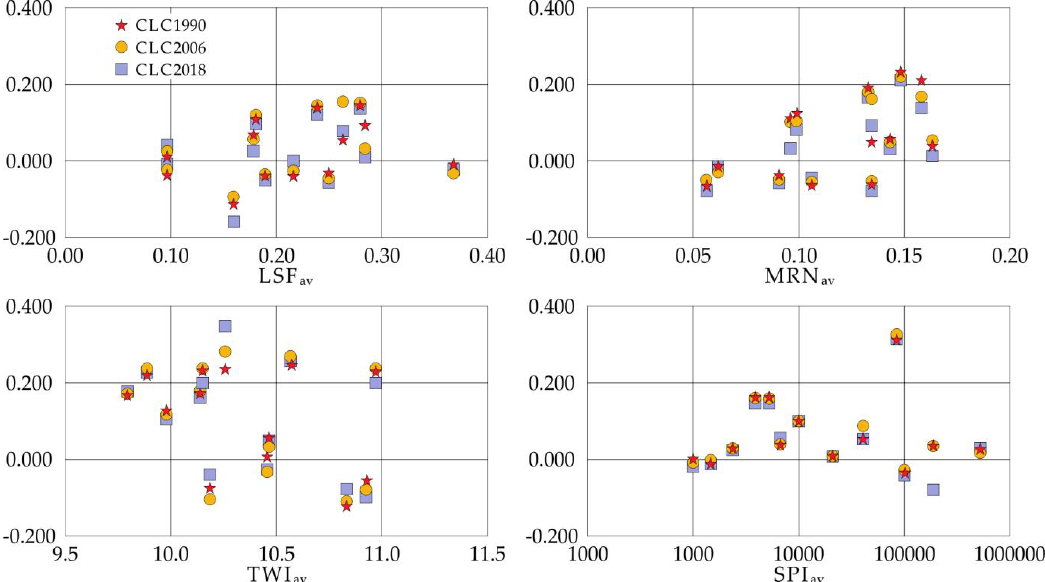
Figure 7. Probability factor for the mean values of the examined morphometric and physical indicators (LS Factor (LSF), Melton Ruggedness Number (MRN), Topographic Wetness Index (TWI), Stream Power Index (SPI) and the types of land cover (CLC 1990, 2006, 2018) in the Brda River catchment area.